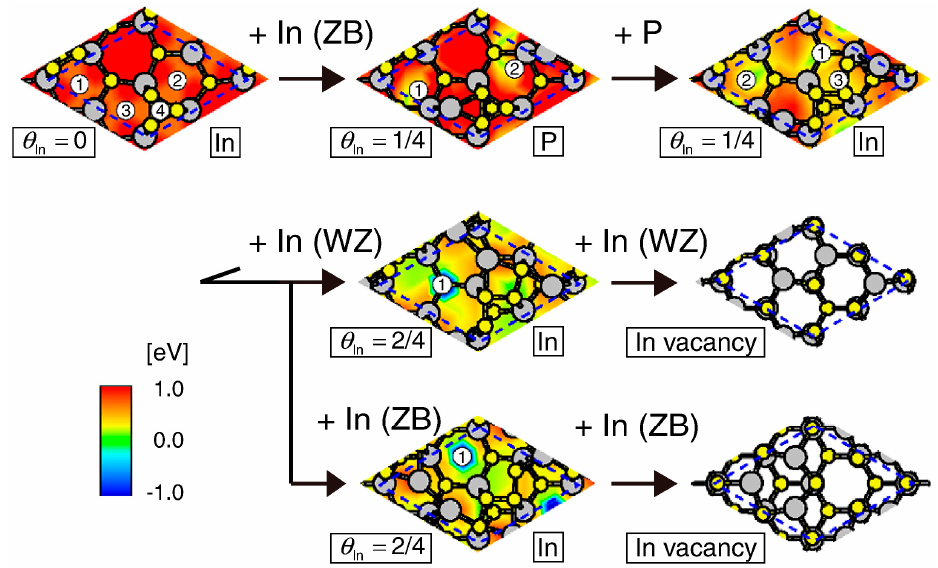
Figure 26. Growth process which is feasible only under the growth condition (B). The adsorption of a P atom occurs on the surface with θ In = 1/4. This growth process splits into two sub-processes after the adsorption of a P atom, and results in the formation of an InP monolayer belonging to the WZ or ZB structure. Reprinted with permission from [97]. Copyright (2013) by